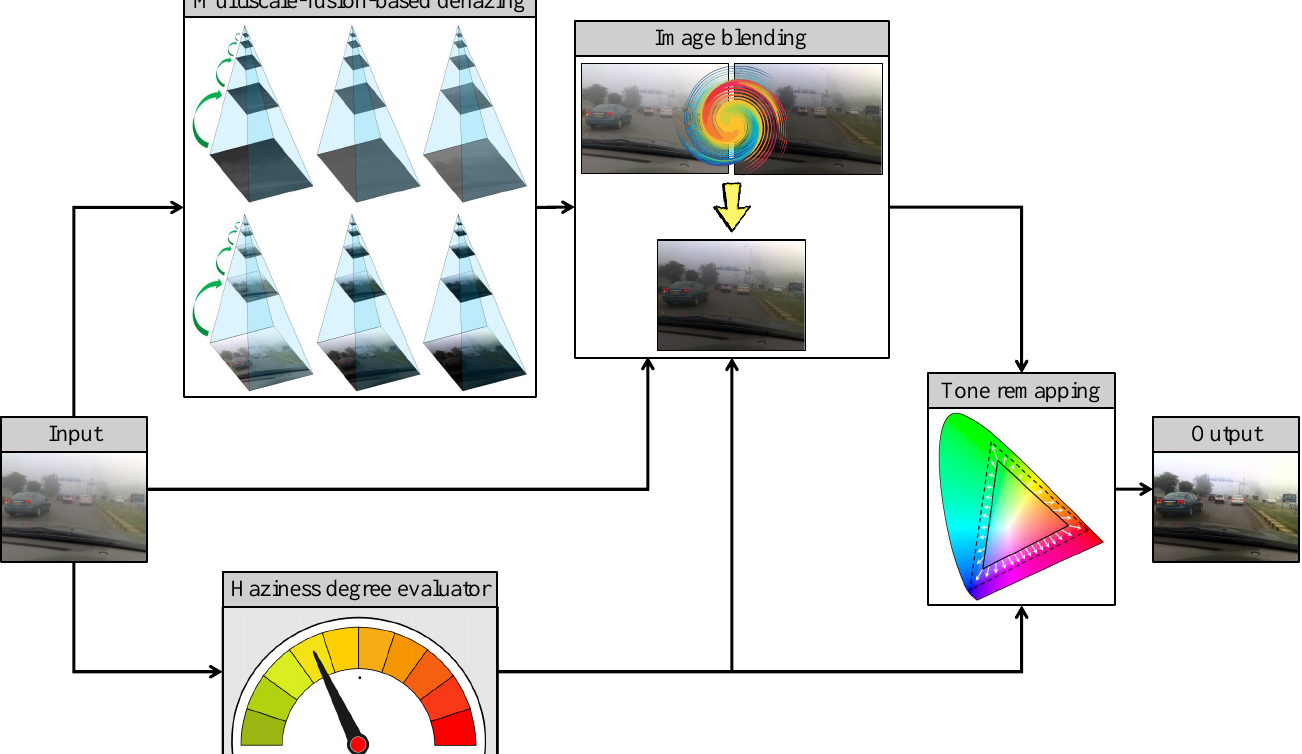
Figure 2. General block diagram of the automated dehazing system (AUDS), founded on multiscale-fusion-based dehazing, haziness degree evaluator, image blending, and tone